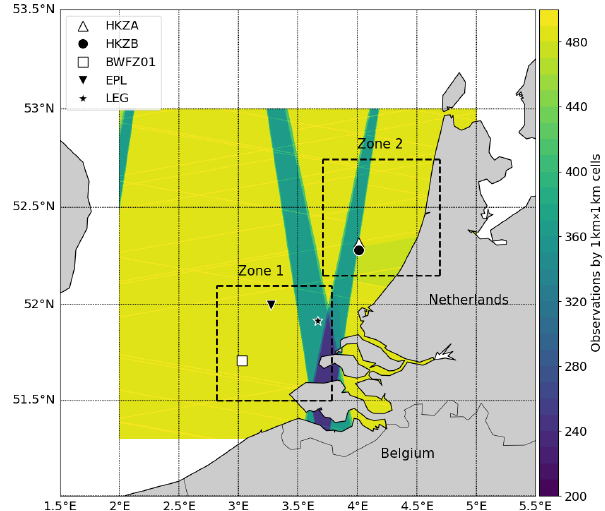
Figure 1. Locations of Zone 1 (bottom; 51.50–52.09 ◦ N, 2.82– 3.77 ◦ E) and Zone 2 (top; 52.15–52.74 ◦ N, 3.71–4.68 ◦ E) with the positions of the profiling lidars. Colours represent the number of Sentinel-1 SAR Level-2 observations over a 2-year period (June 2016 to June